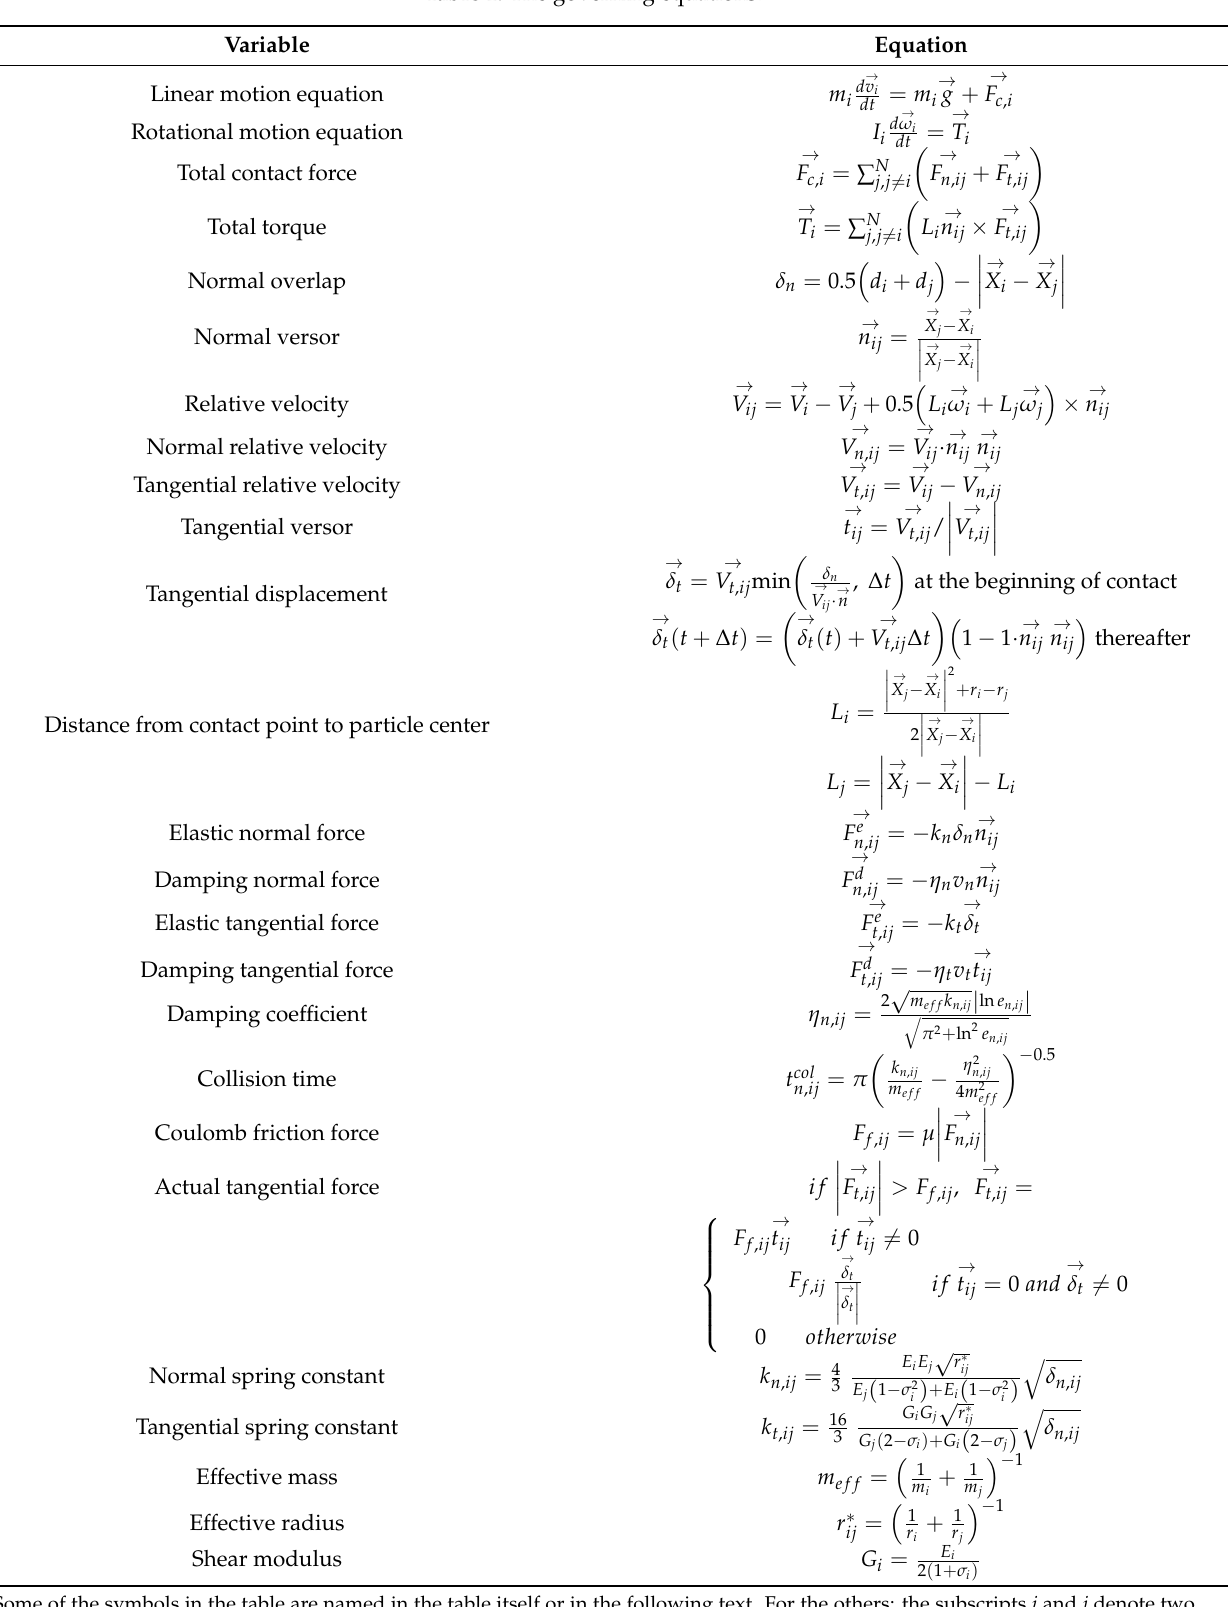
Table 1. The governing